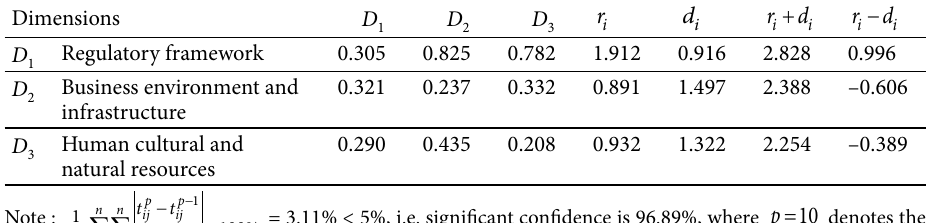
Table 1. Total influential matrix of T and the sum of the effects on the dimensions Dimensions